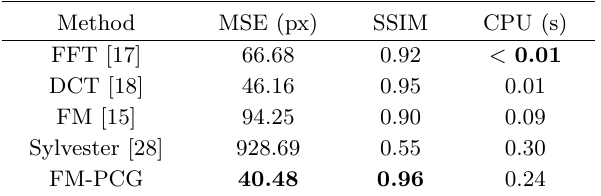
Fig. 14 (a)–(c) Three (out of 12) real-world images, of size 320 × 320, of a photometric stereo dataset. The eyes of the owl are highly specular. This induces a bias in the reconstructions, as shown in the reconstructions using (d) FM or (e) the proposed FM-PCG integrator. (f)–(g) The corresponding MSE of the reprojected images shows that the bias is very localized (blue is 0, and red is > 1000). Table 17 Results on the specular PS dataset (see Fig. 14). All methods present a similar systematic bias due to outliers located on the specular points